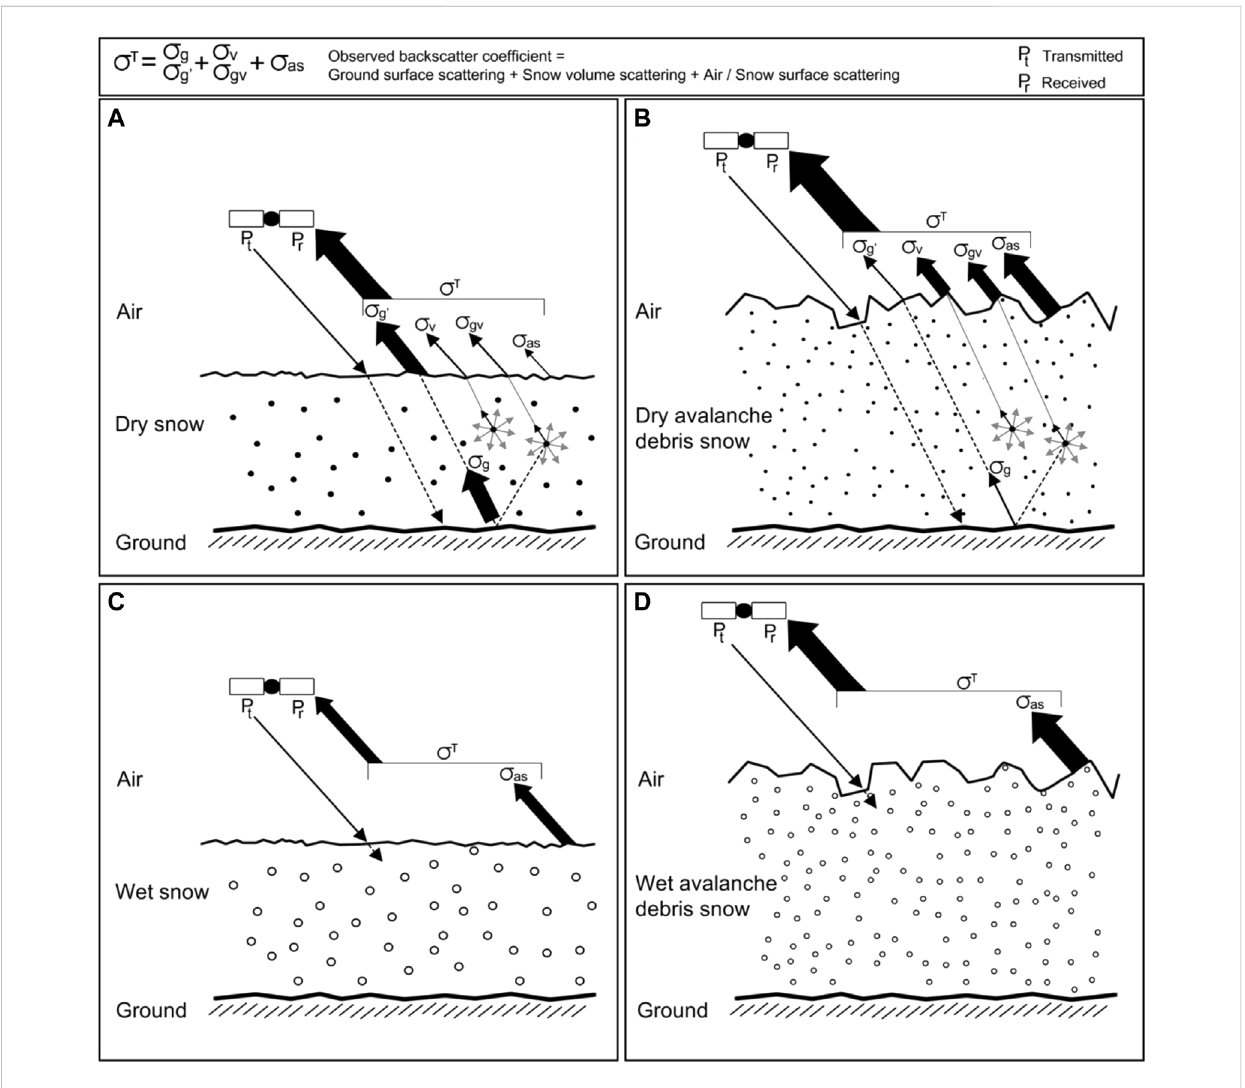
FIGURE 1 (A) Dry snow: The total backscatter ( σ T ) is controlled by the backscatter from the ground ( σ g ). (B) Dry avalanche debris: increased σ T is produced by increased volume backscatter σ v and σ gv and increased backscatter at the air-snow surface interface σ as , which are related to greater snow depths and a higher surface roughness, respectively. (C) Wet snow: the electromagnetic wave is assumed to barely penetrate into the snow volume. Therefore, σ T is predominantly composed of σ as . It is, however, lower than in dry snow. (D) Wet avalanche debris: The surface roughness of the avalanche debris increases the strength of σ T compared to undisturbed wet snow. Reproduced with permission from Eckerstorfer and Malnes